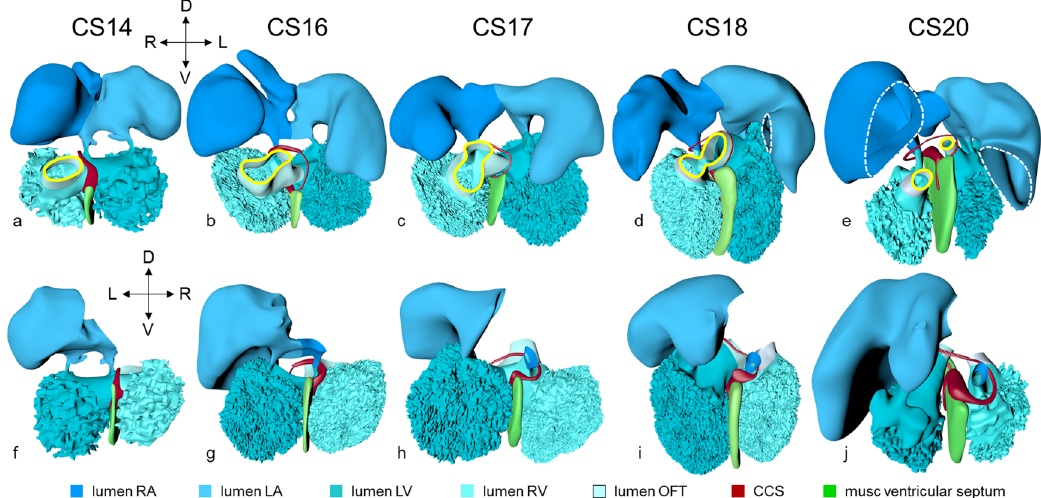
Fig. 5 Pictorial timeline of the subdivision of the interventricular foramen into the peri-tricuspid inlet, the subaortic outlet, and the membranous septum. The fi gure shows the lumens of the atriums, ventricles and out fl ow tract, and the muscular ventricular septum. Panels a – e show a cranial view, and panels f – j a caudal view. When fi rst formed, the interventricular foramen is a sagittally oriented interventricular conduit, as visualized by the GlN-positive ring. The craniodorsal part of the foramen, from which the GlN fades away at CS16, is indicated by a thinner, hatched line. The tips of the atrial appendages are clipped in the images for CS18 and CS20 (dashed lines) to permit inspection of the atrioventricular junction and out fl ow tracts. At CS16, the caudal part of the foramen and GlN ring begin to expand in rightward direction, producing a direct connection between the right atrium and ventricle, which is best seen in panels f – j . Meanwhile, the cranial, subaortic part of the foramen, which is best seen in panels a – e , gradually expands craniodorsally. Comparing the arrangements at CS18 and CS20, when the septation of the out fl ow tract is complete, shows that the subaortic, but not the subpulmonary, ventricular outlet is surrounded by the GlN ring. The remaining connection between the right ventricular cavity and the subaortic channel is still present at CS18. It is obliterated at CS20 by the formation of the membranous septum (not itself visible). All images are also available as preset views in the corresponding